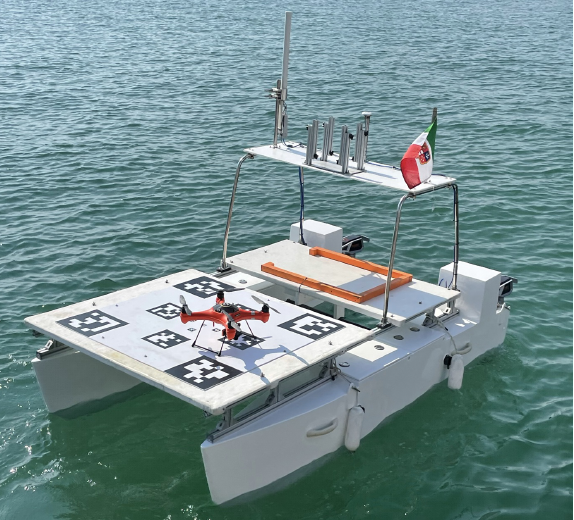
Figure 1. The ULISSE catamaran, equipped with the landing platform and the splash-proof quadrotor, deployed in one of the tests at